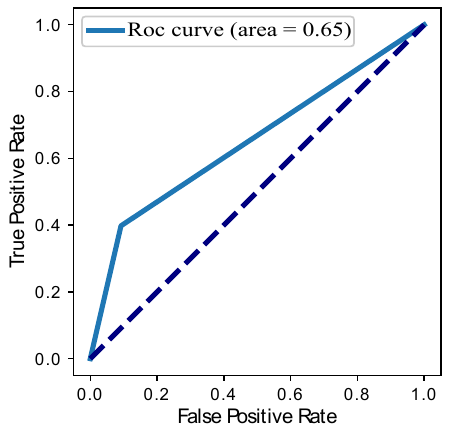
Figure 21. ROC curve of ROC curve of CNN.